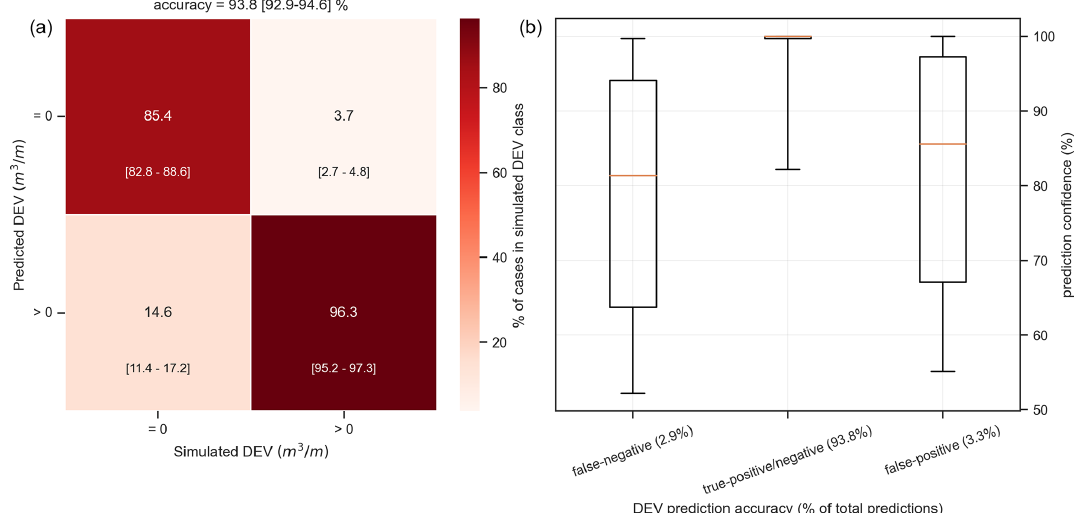
Figure 7. Prediction accuracy of the predicted DEV class using the selected classification ANN configuration (two hidden layers of 32 neurons each) against the XBeach simulated classes for the validation cases. (a) Confusion matrix showing the percentage of each class prediction per observed class (each column sums to 100%), with the diagonal indicating a correct prediction. Numbers in the center of each cell show the mean accuracy over the 10 randomizations of the benchmark cases, while brackets in the lower part give the min–max values. (b) Boxplots of the prediction confidence (as given by the ANN) grouped by the prediction’s accuracy, defined here as the difference between the predicted DEV class and the observed DEV class (orange line: median, box: 25th–75th percentile range, lines: 5th–95th percentile